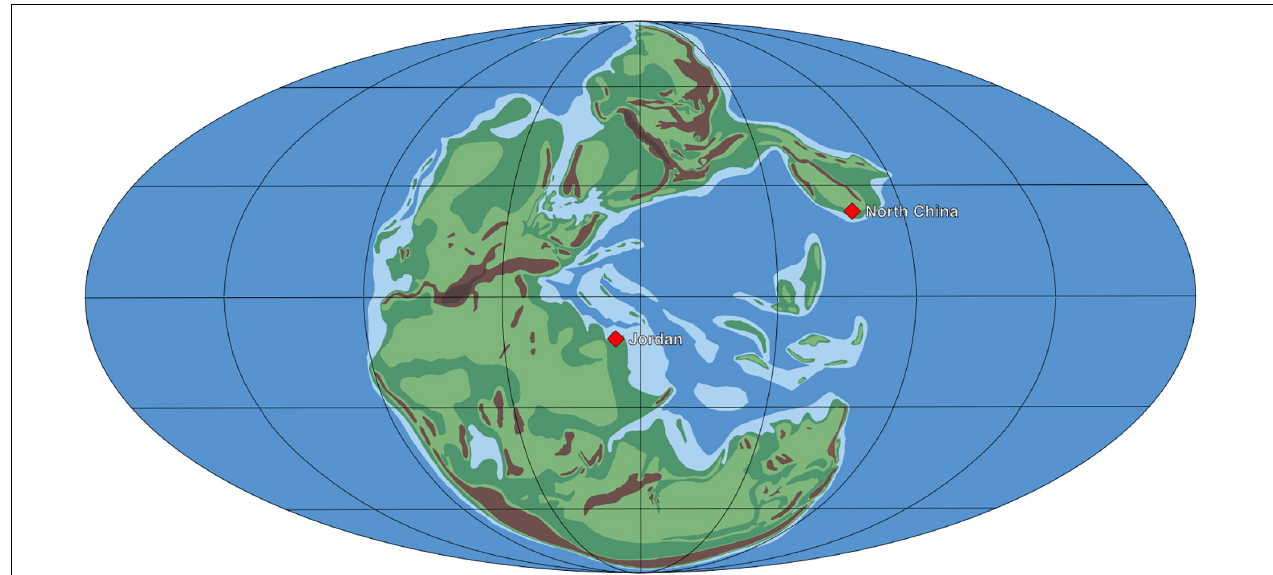
FIGURE 4 | Paleogeographic map of the late Permian with positions of the floras from Jordan and China described herein. Map modified after Ziegler et al.